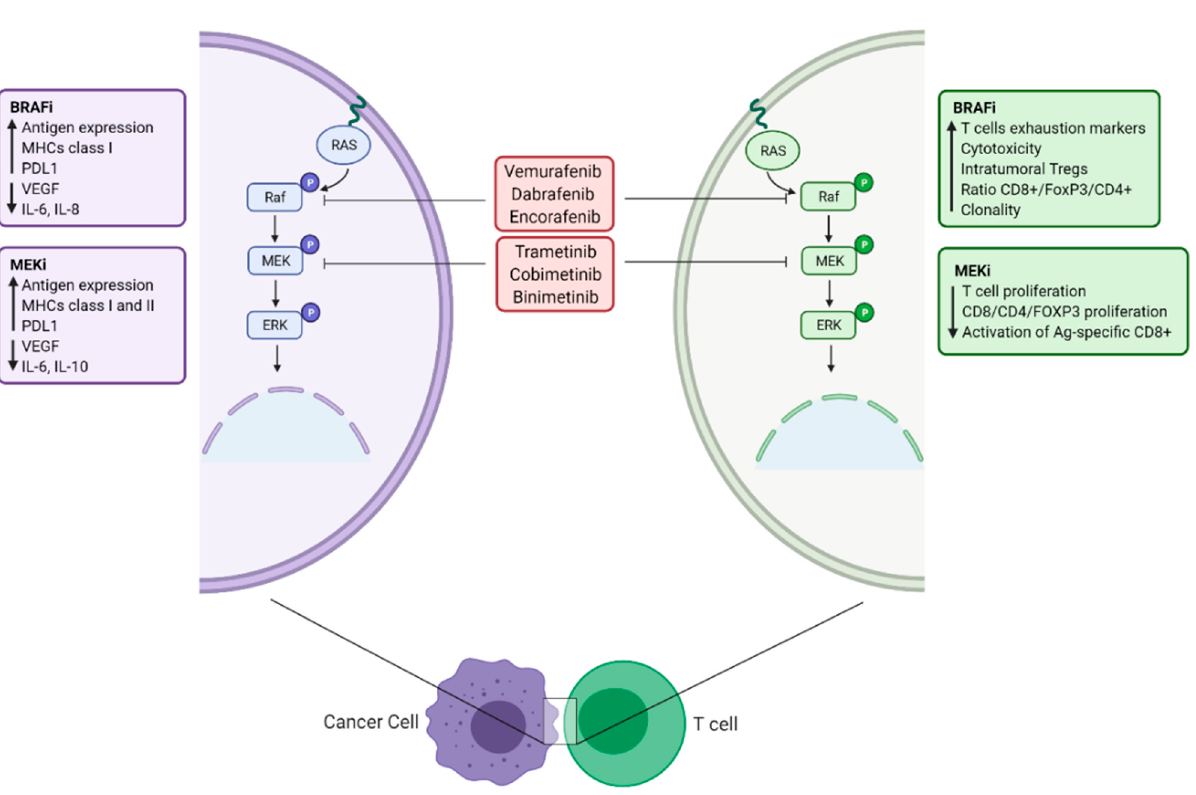
Figure 2. Immunological effects on tumor microenvironment of BRAF and MEK inhibitors. Repre- sentation of the immunological consequences of targeted therapy with BRAFi (vemurafenib, dabrafenib and encorafenib) and MEKi (trametinib, cobimetinib and binimetinib) in a cancer cell (purple) and a T cell (green). Adapted from Bedognetti et al [85]. (Created with BioRender; www.biorender.com,